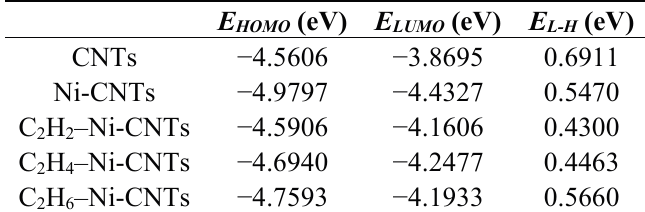
Table 2. Molecular frontier orbital energy and orbital energy